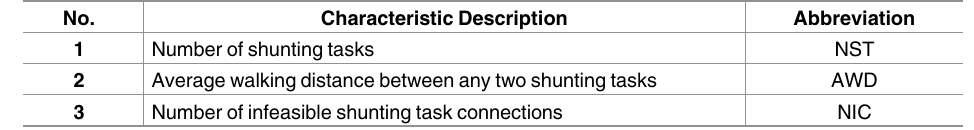
Table 4. Problem characteristics.